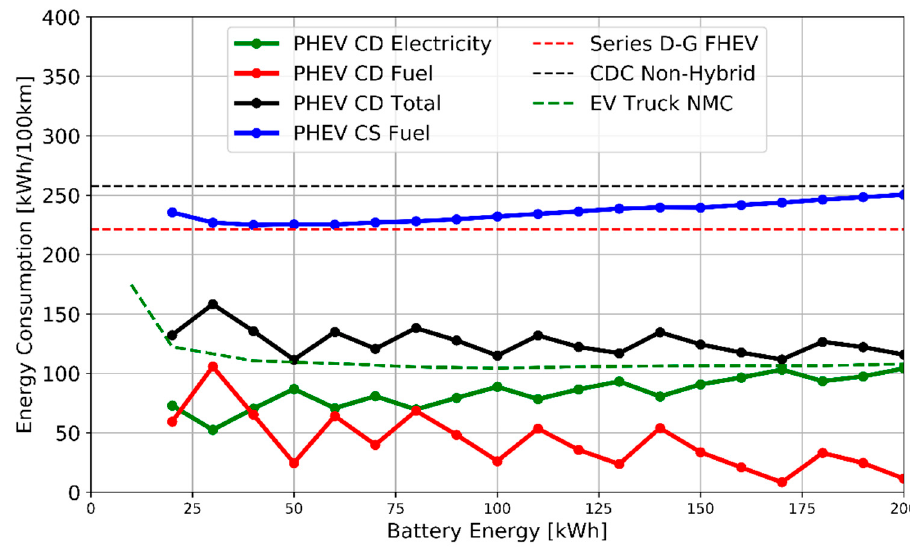
Figure 11. Plug-in hybrid energy consumption divided into energy source (electricity, fuel, and total) and mode (CD and CS) under a WHVC with 50% payload. Nonhybrid, full hybrid, and pure electric are added for comparison.